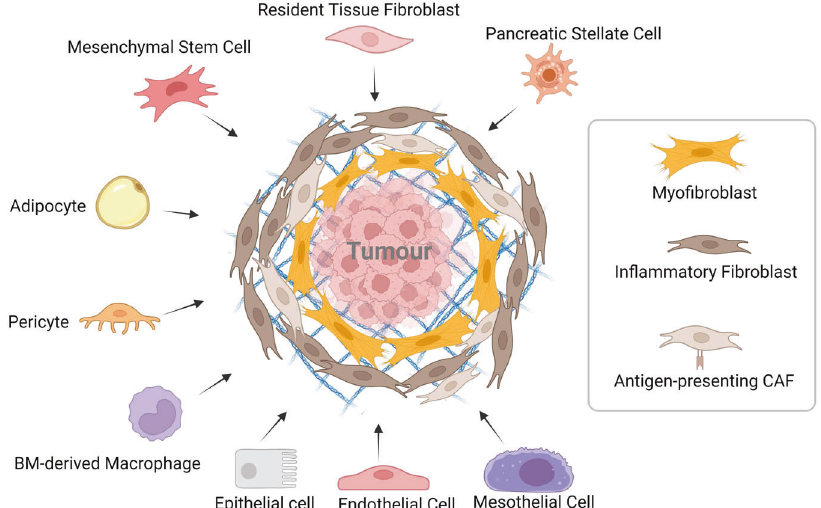
Fig. 1 Heterogeneity of CAFs in PDAC. CAFs in PDAC originate from diverse cells. PSCs and other resident tissue fi broblasts can be activated into cancer-associated fi broblasts. Cytokines and chemokines in the TME can cause MSCs, pericytes and adipocytes to differentiate into CAFs and be recruited to the tumour. A subset of BM-derived macrophages concerts into CAF-like cells, promoting pancreatic cancer progression. Transdifferentiation allows epithelial, endothelial, and mesothelial cells to join the CAF population. myCAF, iCAF and apCAF are different phenotypes of CAFs in PDAC that have been discovered. myCAF is spatially located close to the tumour, whereas iCAF is further away from the tumour; apCAF is a smaller subset that promotes immunosuppression in the tumour